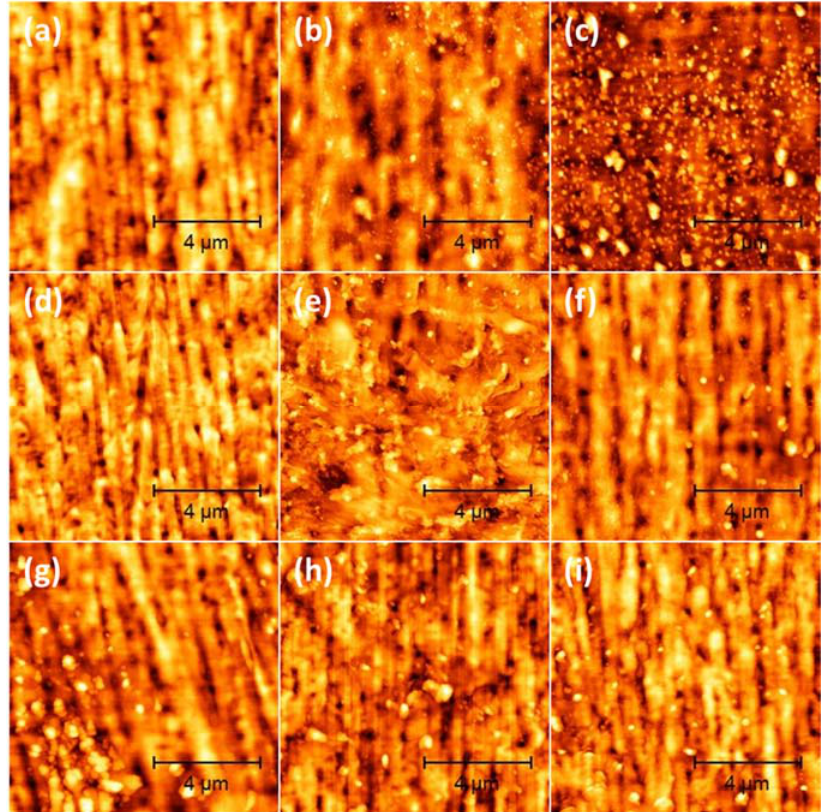
Figure 2. AFM pictures of ( a ) untreated PBS, ( b ) O 2 ‐ plasma ‐ treated for 30 s, ( c ) O 2 ‐ plasma ‐ treated for 120 s, ( d ) Ar/O 2 ‐ plasma ‐ treated for 30 s, ( e ) Ar/O 2 ‐ plasma ‐ treated for 120 s, ( f ) O 2 plasma 30 s + Ar plasma 240 s, ( g ) O 2 plasma 60 s + Ar plasma 240 s, ( h ) O 2 plasma 30 s + Ar plasma 60 s, and ( i ) O 2 plasma 30 s + Ar plasma 120 s.